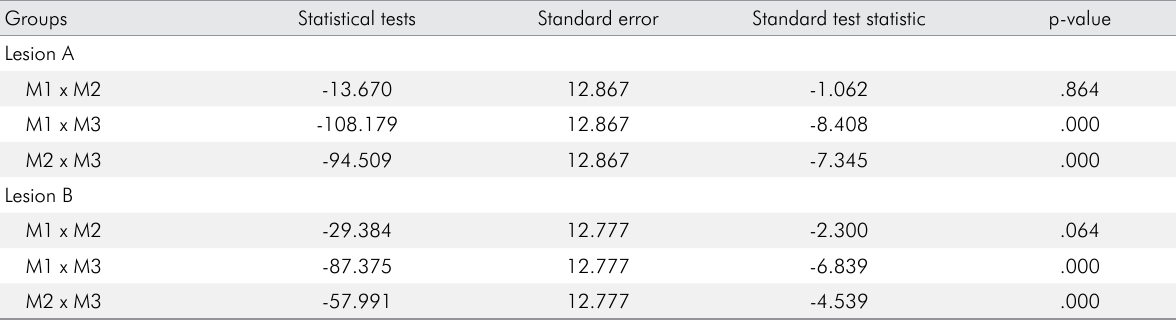
Table 2. Analysis between groups (M1, M2 and M3) of lesions A and B descriptions, performed by the Dunn`s test. Groups